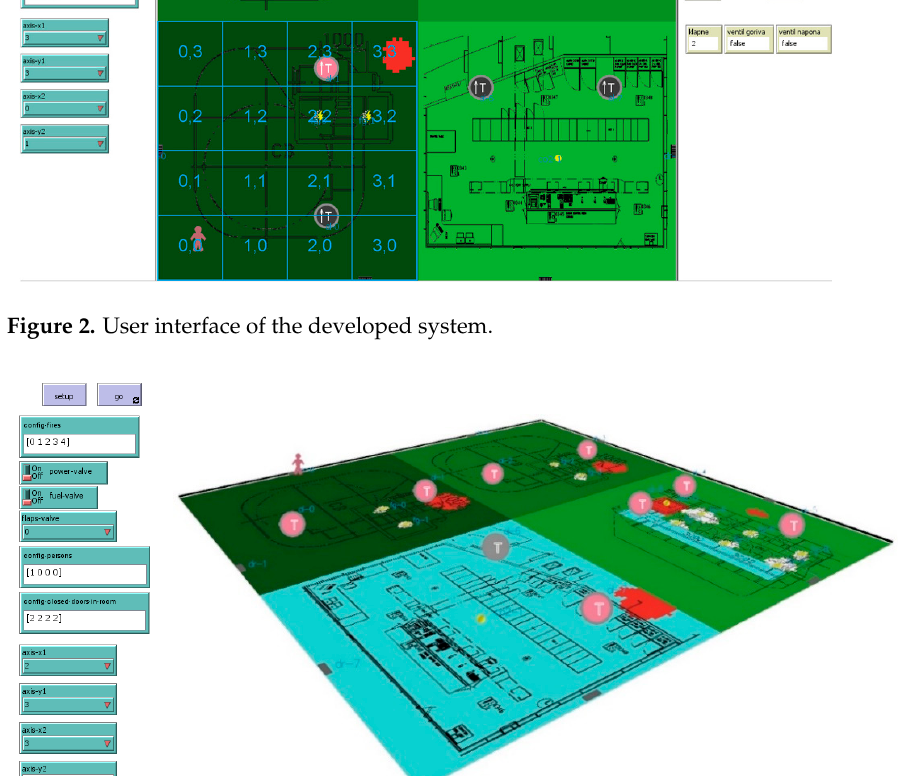
Figure 3. Simulation of simultaneous fire in all rooms.